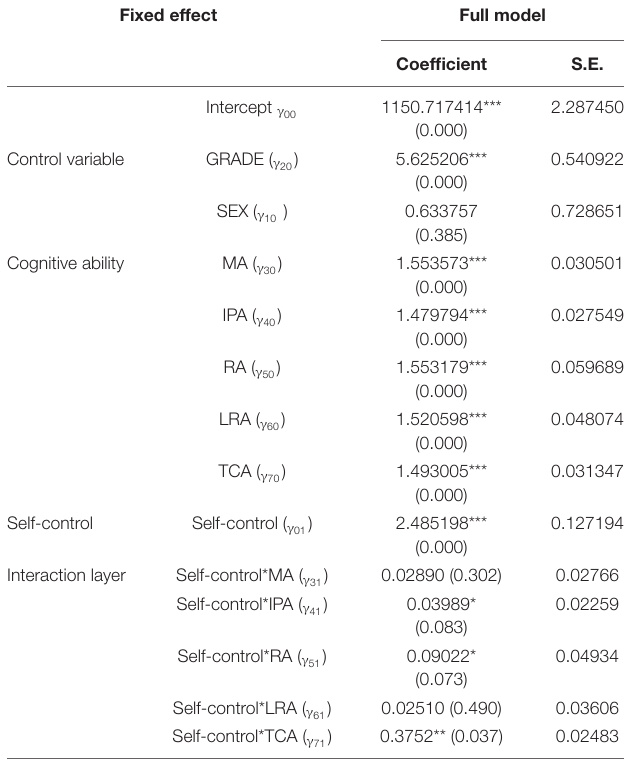
TABLE 3 | Hierarchical linear model regression